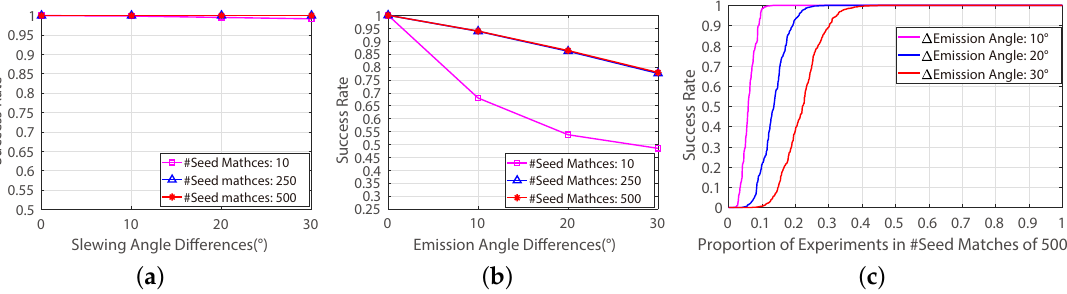
Figure 3. The success rates of the rectification method performed on the 7000 simulated datasets. ( a ) The success rates on datasets with various differences of slewing angles. ( b ) The success rates on datasets withe various differences of emission angles. ( c ) The success rates on datasets with 500 seed-matches and various differences of emission